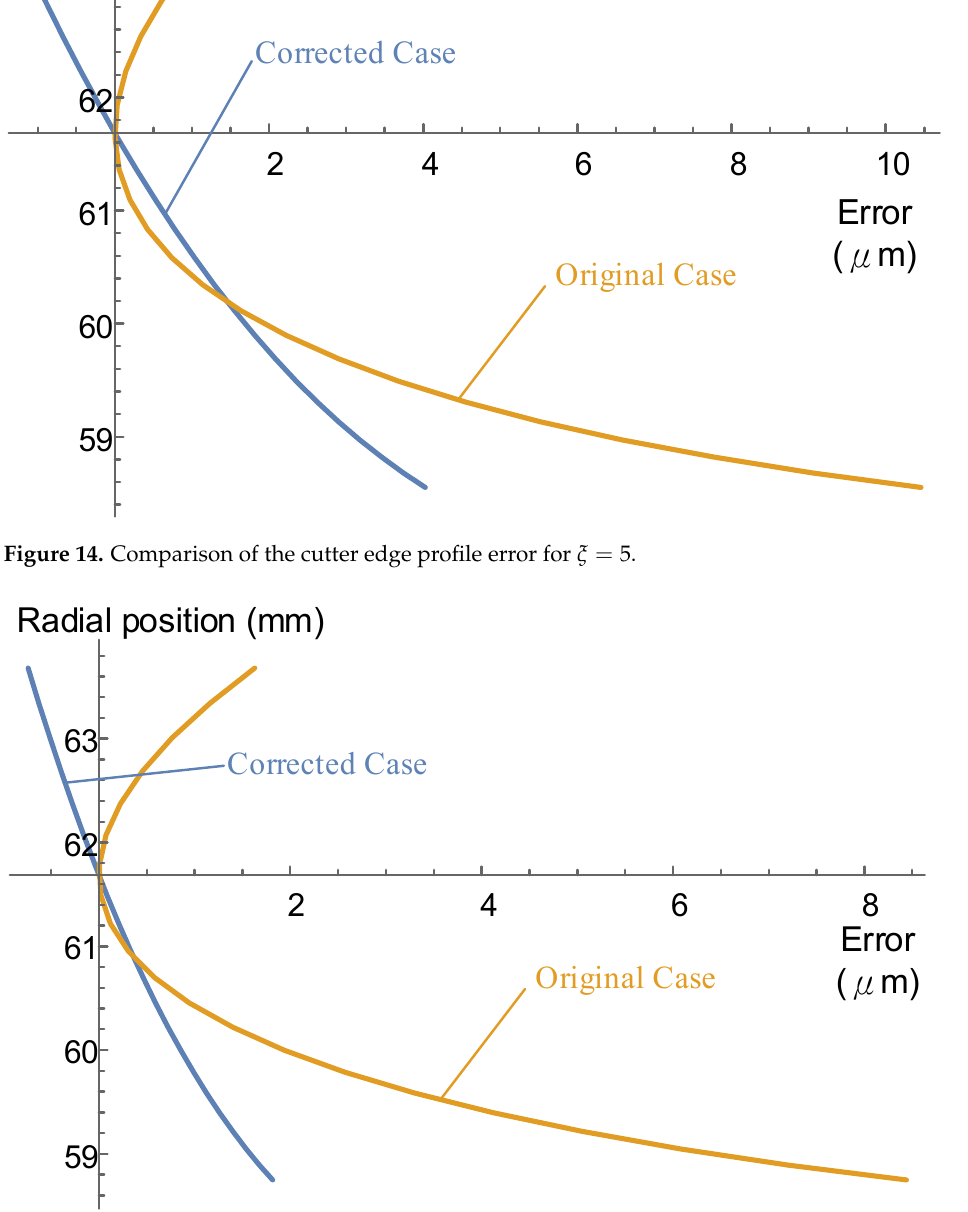
Figure 15. Comparison of the cutter edge profile error for ξ = 2.5. Figures 16 and 17 show the results of the cutter faces ξ = − 2.5 and ξ = − 5, respectively. In cases of negative profile shifting, after correcting the cutter edge, the shaping cutter still has better form accuracy. For the case of ξ = − 5, the pressure angle error of the uncorrected case performs better than that of the corrected case. However, ξ = − 5 is close to the end of the cutter’s